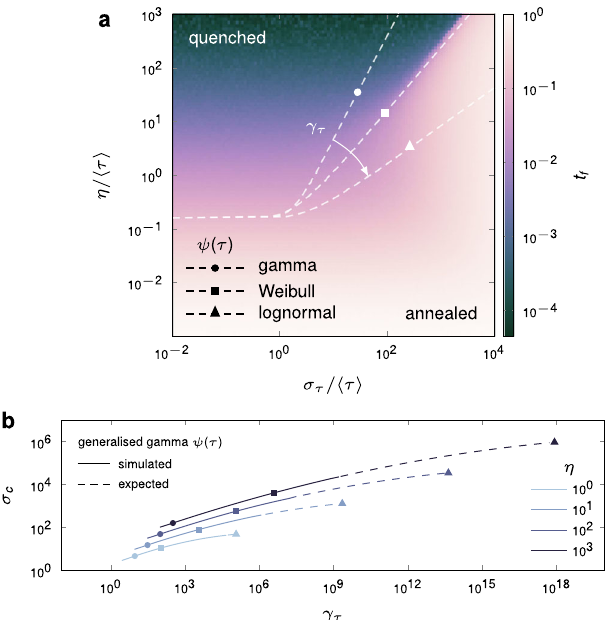
Fig. 4 Collapse of the giant temporal component due to increasing burstiness. a Heat map is diffusion time t f for an SI process with λ = 0.02 under a Weibull interevent time distribution, and a step-function memory kernel. The underlying degree distribution is lognormal with 〈 k 〉 = 7 and σ k = 0.5, and network size N = 10 5 . The slope of the temporal network phase transition, dashed lines, depends on the choice of the interevent time distribution, and can be parameterised by its skewness, γ τ . b For a given η , the critical σ c varies for the gamma, Weibull and lognormal distributions, which are special and limiting cases of the generalised gamma distribution, parameterised here by γ τ . Solid lines in b result from simulating the temporal network with smoothly varying γ τ under the generalised gamma distribution. Symbols are data taken from a , the results of direct simulation of the gamma, Weibull and lognormal distributions. Dashed lines are extrapolation from solid lines to lognormal